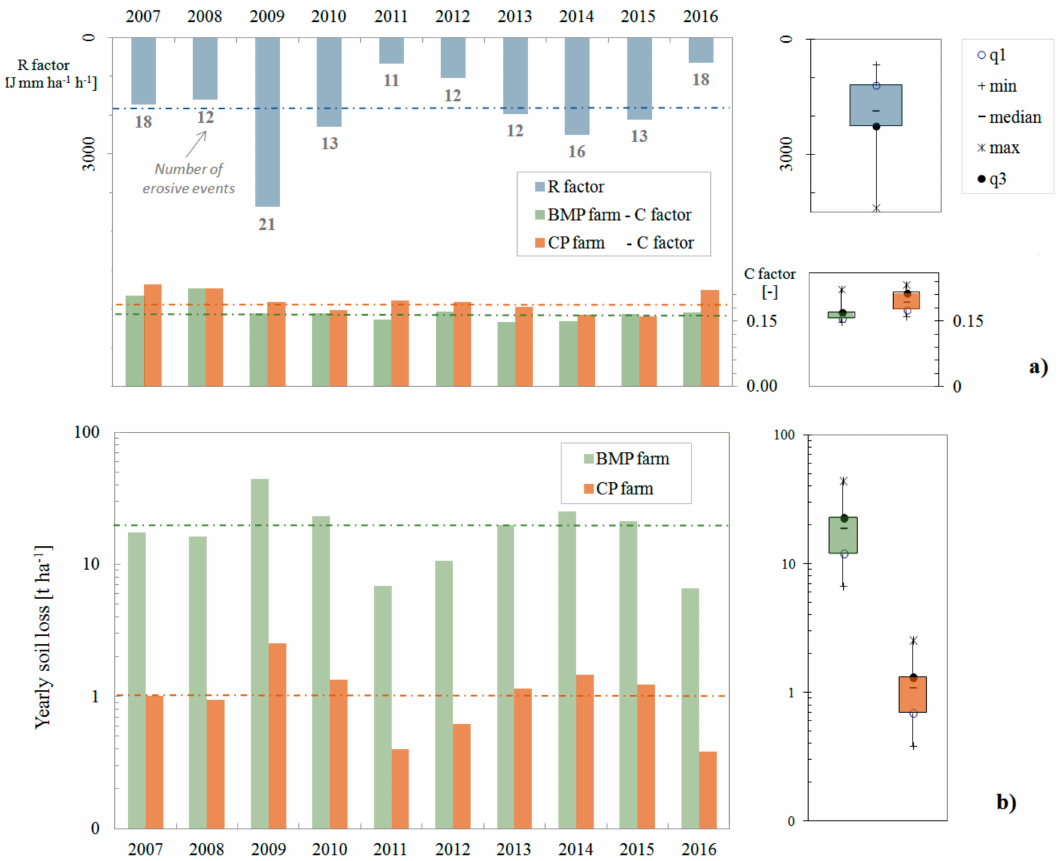
Figure 5. ( a ) Rainfall erosivity (R) and cover management (C) factors and ( b ) output results of the RUSLE model applied at average yearly and annual time scale. In the right of both figures the box-plots of the corresponding variables are also reported (q1 and q3 are the first and the third quartiles).